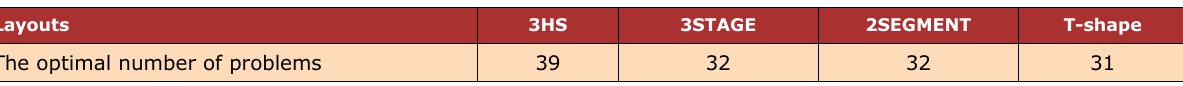
Table 3. The optimal number of different